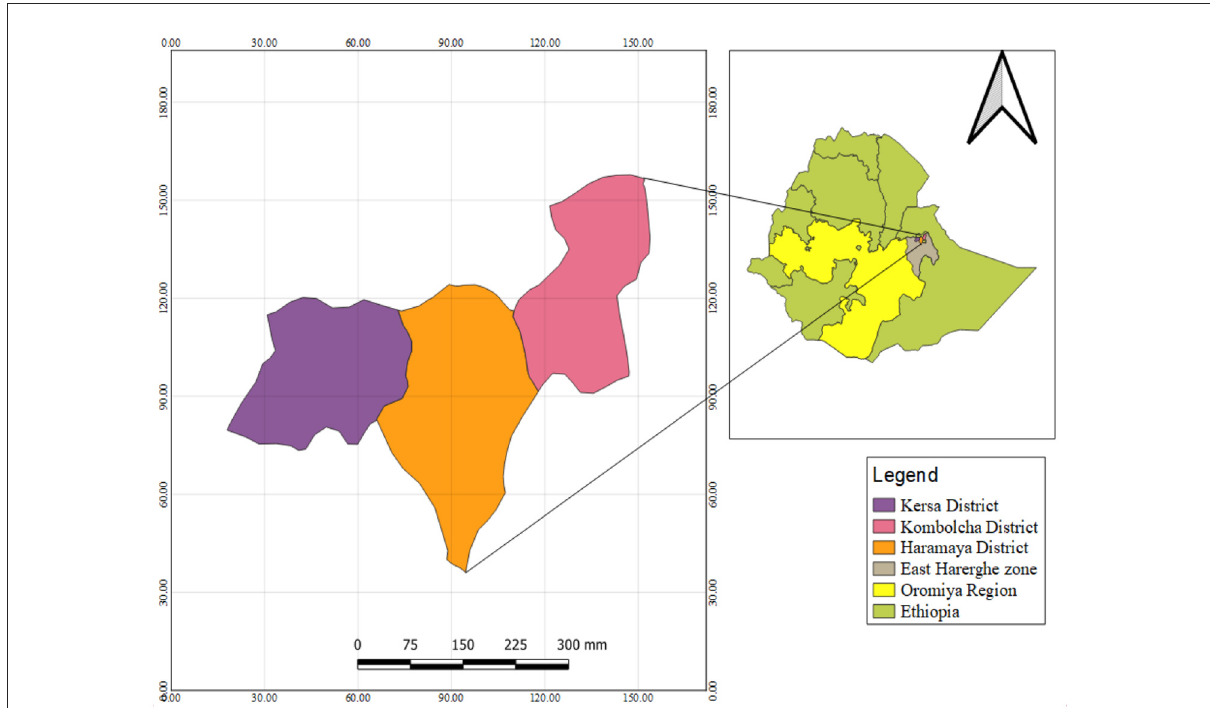
FIGURE1 Map of the study area, Kersa, Kombolcha, and Haramaya districts, East Hararge Zone, Oromiya Region,